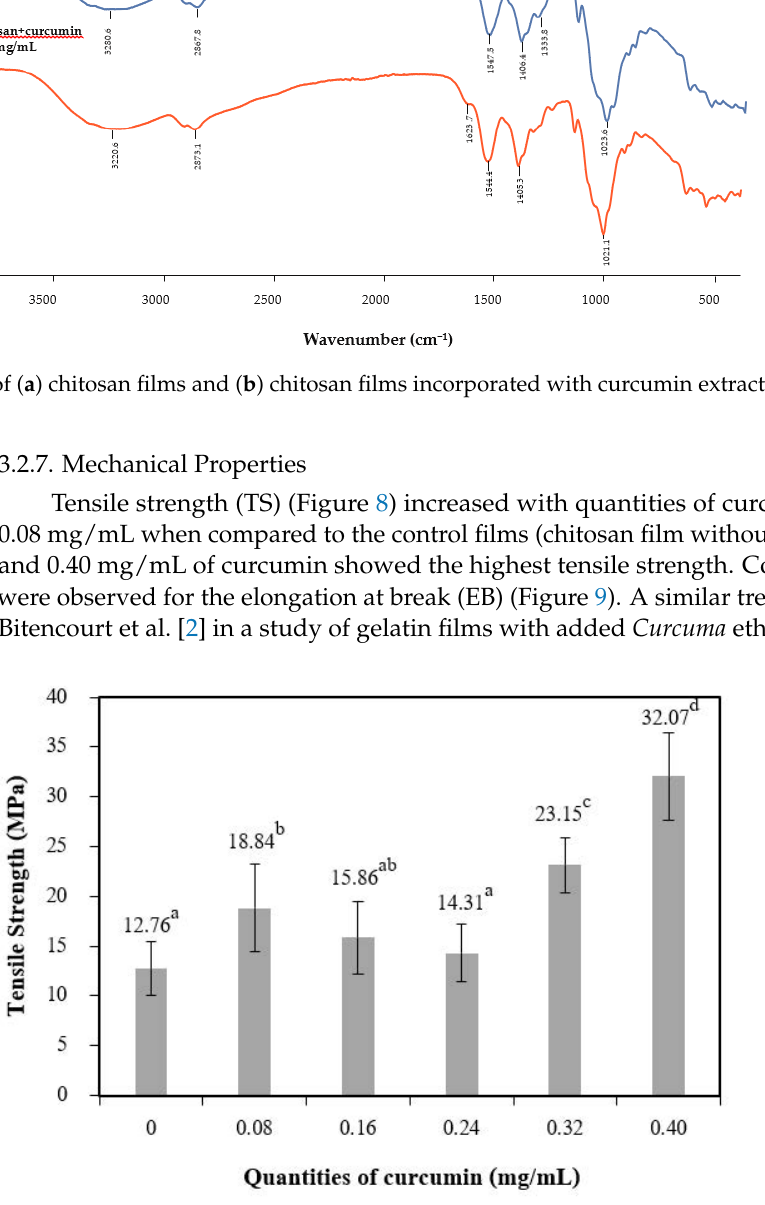
Figure 8. Tensile strength of chitosan film incorporated with various curcumin quantities. Results marked with different letters are statistically different ( p <